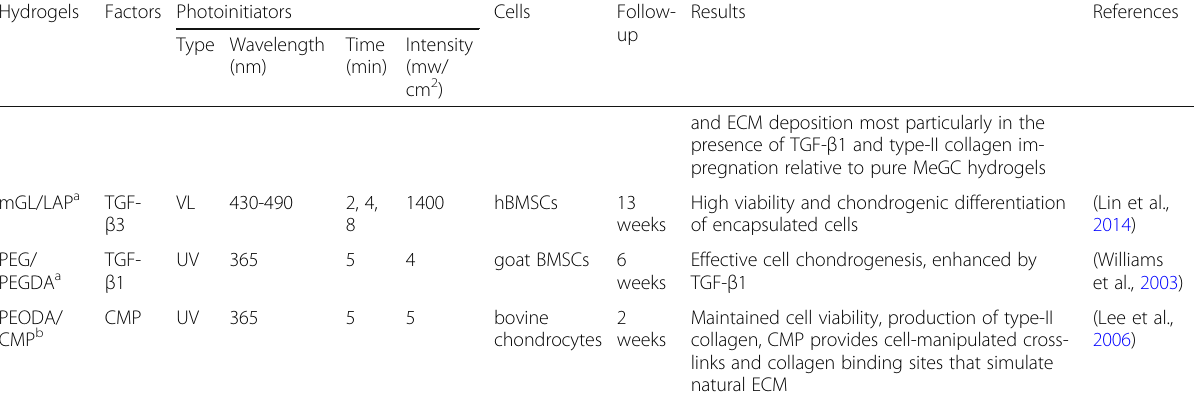
Table 1 Use of photopolymerizable hydrogels in vitro for applications in cartilage research (Continued) Hydrogels